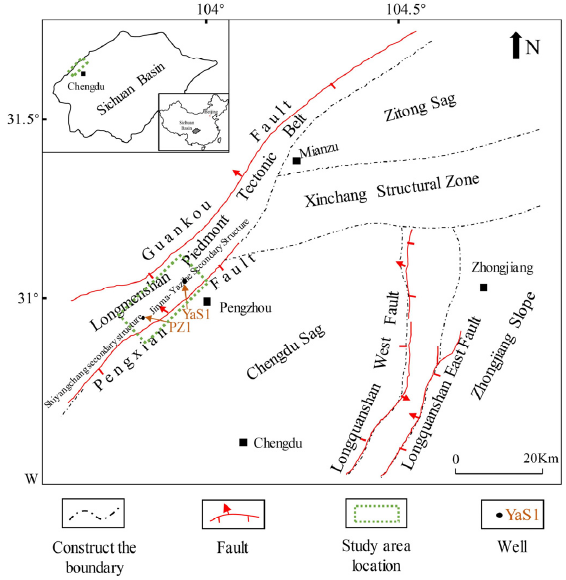
Figure 1. Structural unit division and location of the study area in the western Sichuan basin.